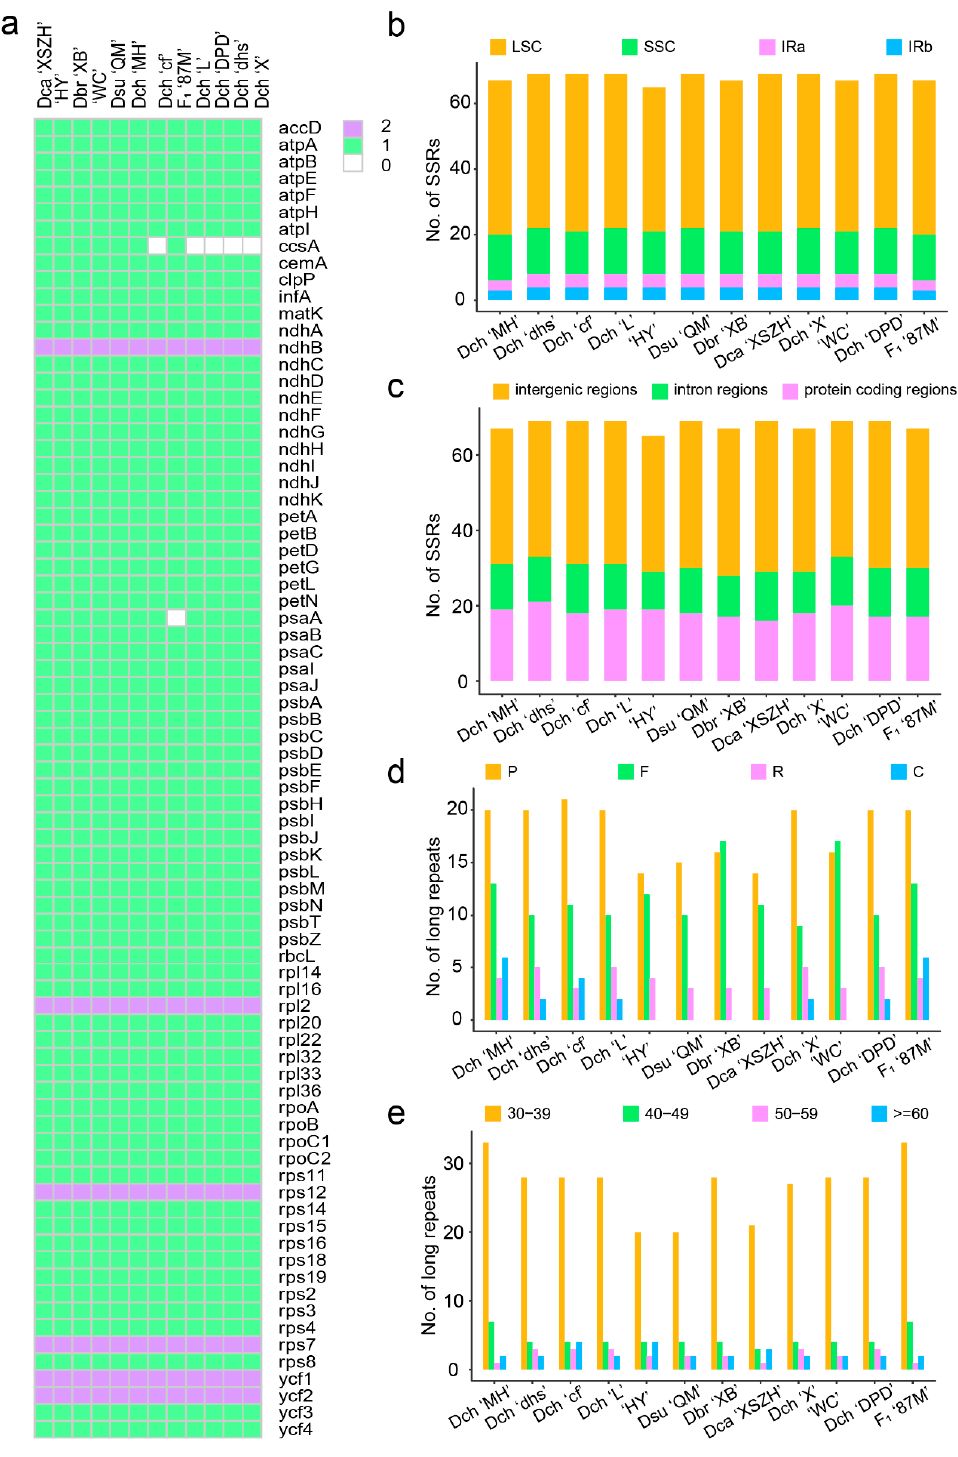
Figure 3. Protein coding gene content and repetitive sequence feature of 12 Dianthus chloroplast genomes. ( a ) Protein coding gene content of 12 Dianthus chloroplast genomes. Different colors represent the number of genes appearing in each chloroplast genome. ( b ) The frequencies of the identified SSRs in the LSC/SSC/IR regions. ( c ) The SSR distribution in protein coding regions, intron regions, and intergenic regions detected in 12 Dianthus chloroplast genomes. ( d ) A total of four long repeat types in 12 Dianthus chloroplast genomes. F, Forward; R, Reverse; C, Complement; P, Palindromic. ( e ) The numbers of long repeat sequences by length.